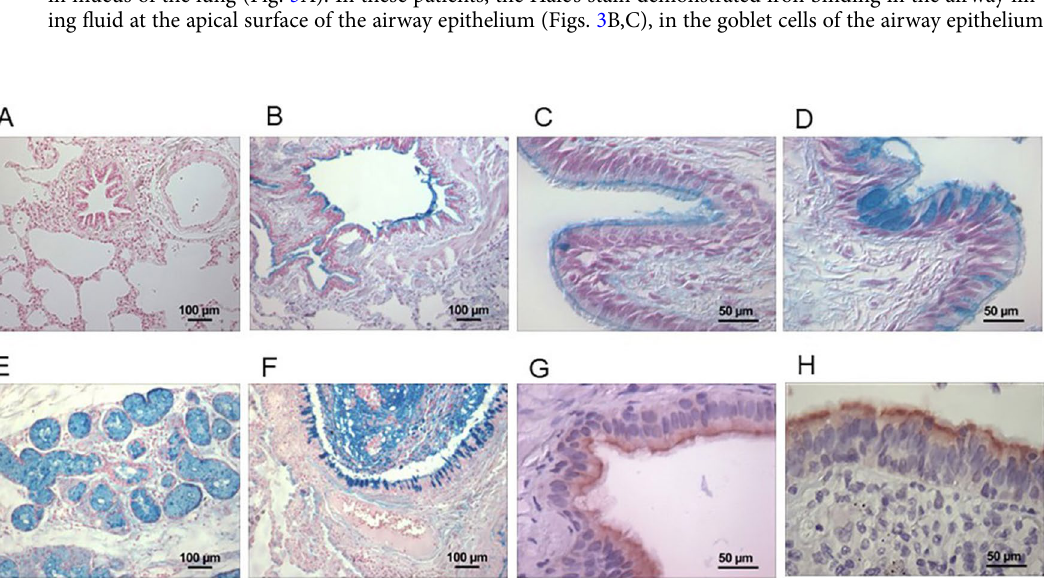
Figure 3. In situ iron binding by mucus and immunohistochemistry. Lung tissue from six patients diagnosed with COPD was stained for iron (Perls’ stain) and iron-binding (Hale’s stain). Photomicrographs were obtained using With Perls’ stain of the tissues, there was no airway iron associated with mucus ( A ). However, the Hale’s stain of every lung tissue demonstrated iron uptake (blue) at the apical surface of the airway epithelium ( B , C ), in goblet cells in the epithelium ( D ), and in the submucosal glands ( E ). Accumulation of mucus in inflamed, proximal airways of patients with COPD similarly corresponded to metal uptake with Hale’s stain ( F ). Immunohistochemical staining for DMT1 ( G ) and ferritin ( H ) demonstrated both (brown) at the apical membrane of the ciliated airway epithelium. These stains localized the expression of iron transport and storage proteins to the apical membrane, immediately adjacent to the mucus. Original magnification: ( A , B , E ) and ( F ) × 100; ( C , D , G ) and ( H ) ×